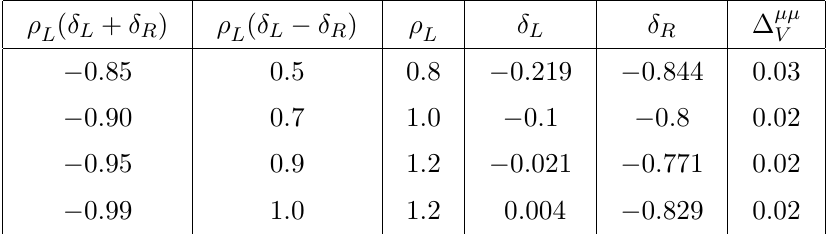
Table 4 . The quark- Z 0 coupling parameters (cid:26) and (cid:14) L;R corresponding to a few sample sets of L (cid:26) ( (cid:14) L (cid:6) (cid:14) R ) and (cid:1) (cid:22)(cid:22) in the (cid:26) = 0 : 1 (cid:26) and m = 1 TeV case. L R L Z 0 V inferred in ref. [97] from the study on LHC bounds in ref. [98]. For the lepton sector, the